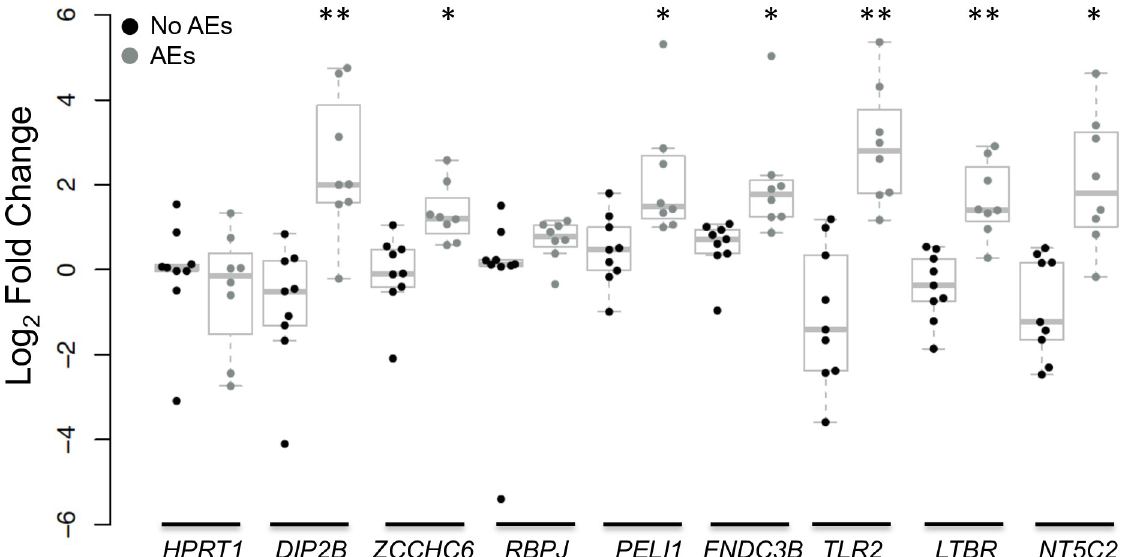
Fig 6. qRT-PCR validation of RNA-seq data. Post-treatment fold change of the top eight genes identified by random forest analysis. Seven of the genes ( DIP2B , ZCCHC6 , PELI1 , FNDC3B , TLR2 , LTBR and NT5C2 ) significantly increase only in individuals with moderate adverse events (AEs) (n = 8) compared to individuals with no AEs (n = 9). � P < 0.05, �� P < 0.001 by t-tests. HPRT1 is a housekeeping gene that should not change with treatment in either AE group.